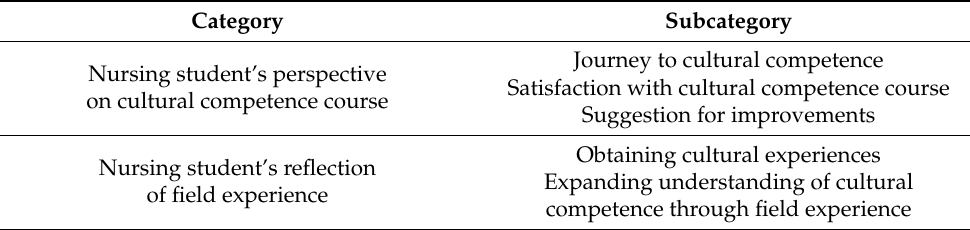
Table 6. Qualitative results of effects of cultural competence course.